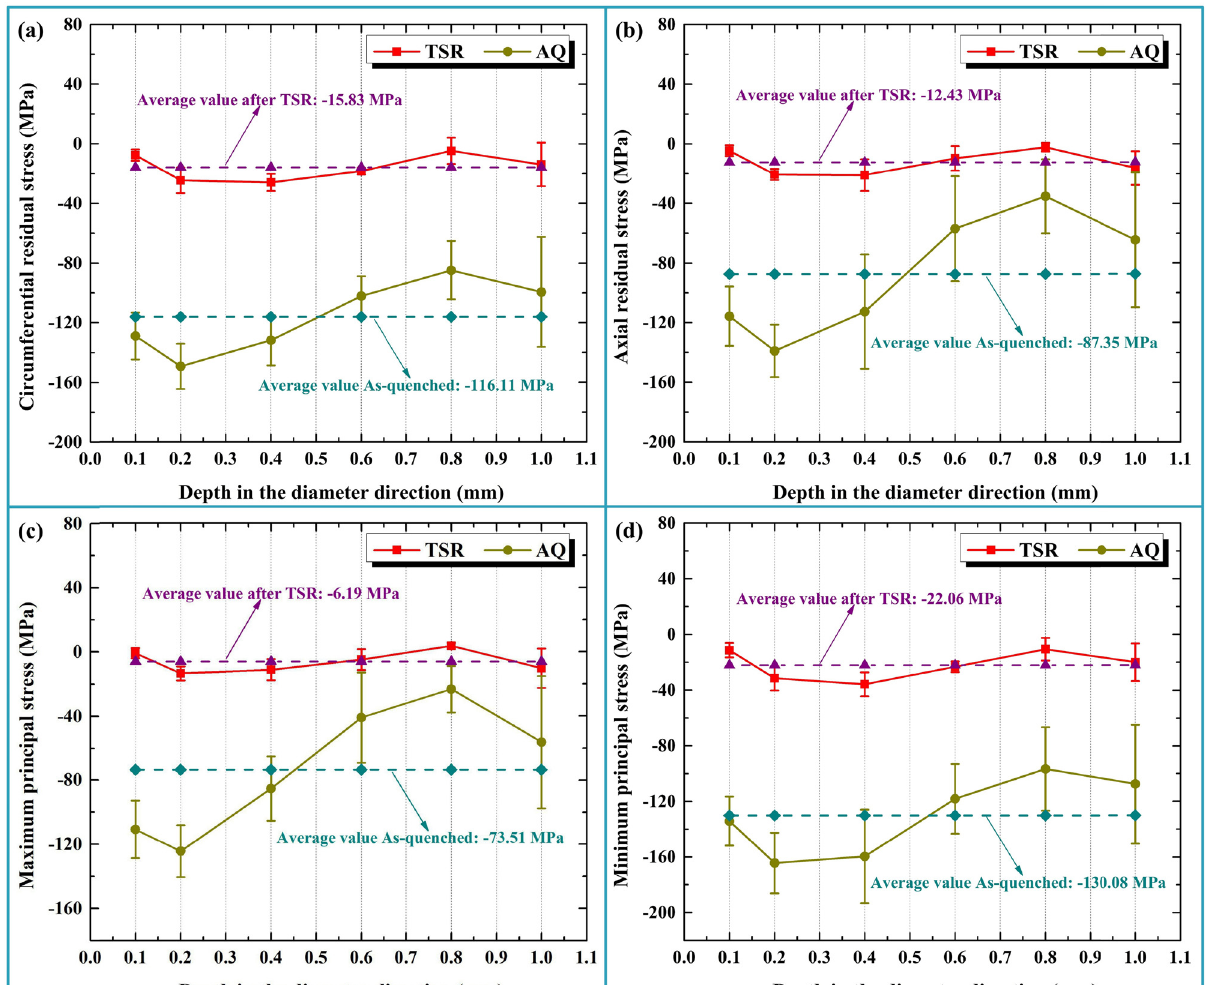
Figure 3: Comparison of residual stress distribution along the depth between the AQ piece and the TSR piece: ( a ) circumferential residual stress, ( b ) axial residual stress, ( c ) maximum principal stress, and ( d ) minimum principal